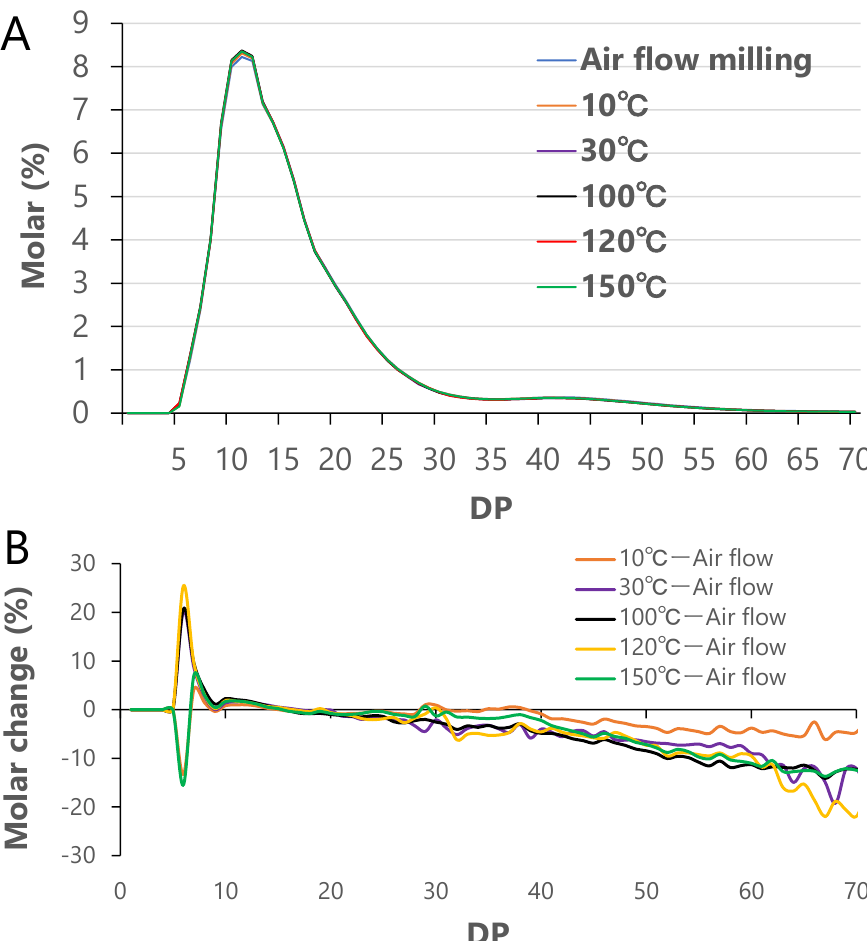
Figure 4. Chain-length distributions for rice flour prepared by SHMM treatment at different tem- peratures and crystalline rice flour by air flow milling as determined using the FACE method. (A) Molar percentage for each liberated chain to the total chains after debranching starch. (B) Rate of molar change in chain length distribution for each rice flour by SHMM treatment at different temperature compared to air flow milling (ΔMolar[%] / Molar[%] × 100).